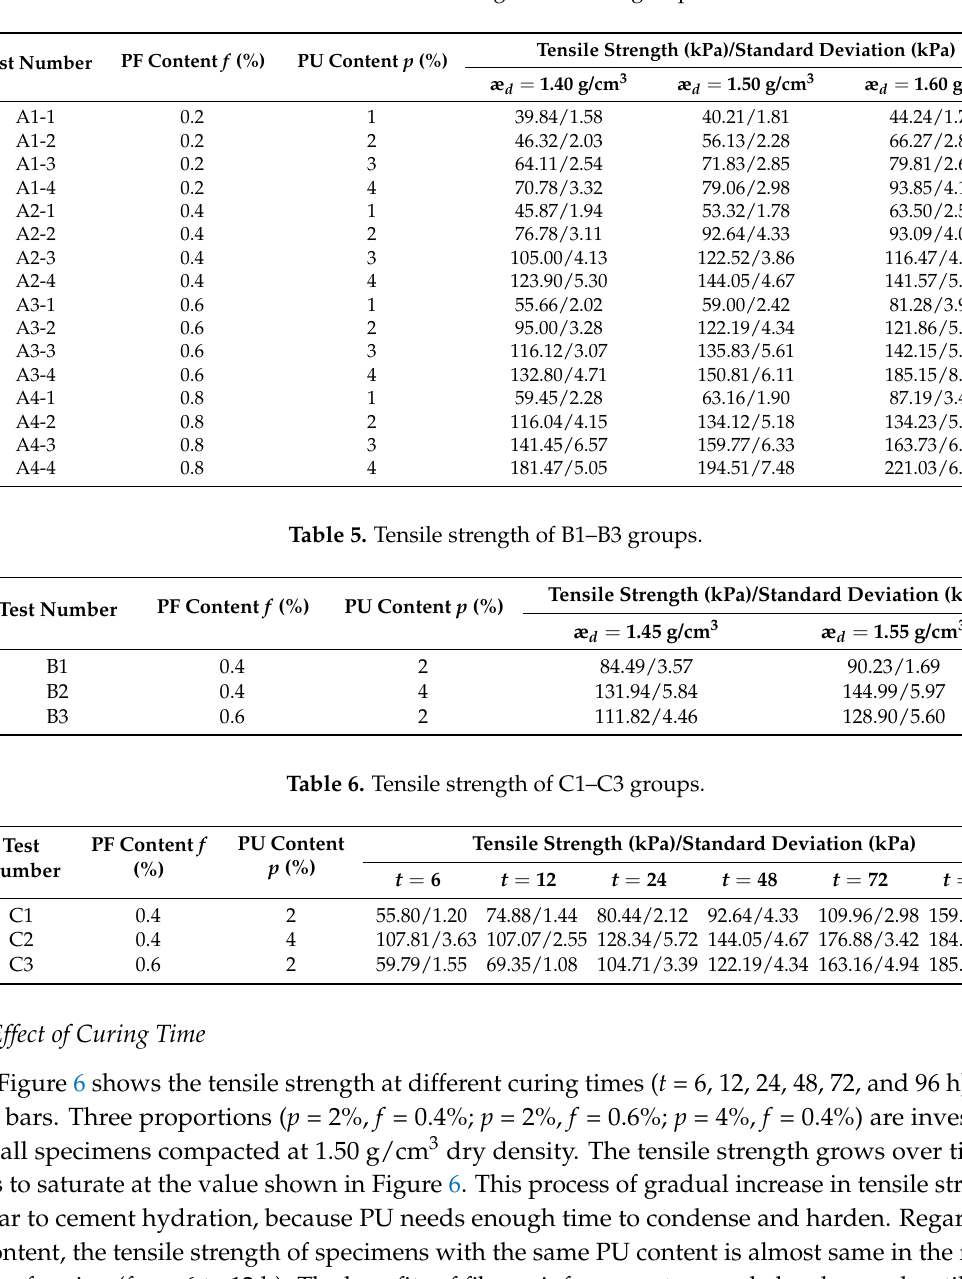
Table 4. Tensile strength of A1–A4 groups.